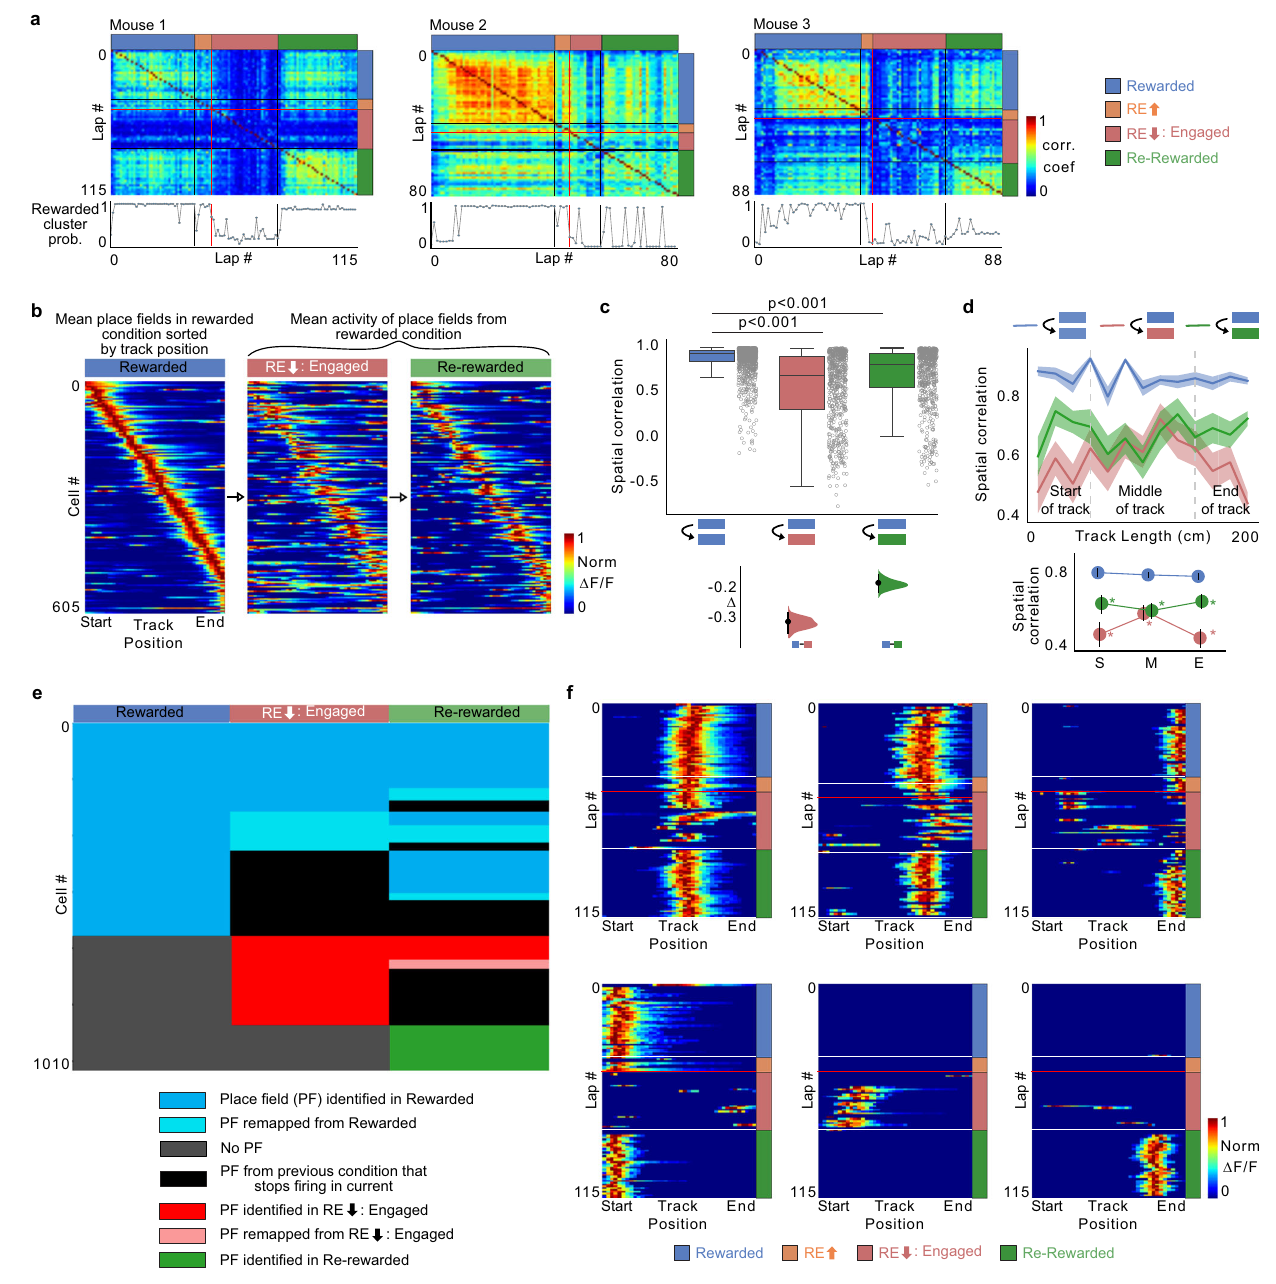
Fig. 2 | Diminishedreward expectationleadstoplace cellremapping across all track locations and loss of reward overrepresentation. a (Top) Population vector correlations between place cell activity in each lap in all conditions in 3 animals. In laps with low reward expectation, only Engaged laps were used (RE low : Engaged).(Bottom)ProbabilityoflapsbelongingtotheRewardedclusterfollowing 1000 iterations of k -means clustering (see Methods). Red line indicates the lap wherepre-lickingstops,andblacklinesdivideeachcondition. b Place fi eldsde fi ned inRplottedacrossallconditions.Activityofeachplacecellwasnormalizedtopeak inRandsortedbyitscenterofmassalongthetrack. c Boxplotsshowdistributionof place fi eld spatial correlation for cells (circles) within R condition (blue) and between R and other conditions. P values were obtained using two-sided paired t test. (Bottom) Bootstrapped mean differences ( Δ ) with 95% CI (error bar). X -axis